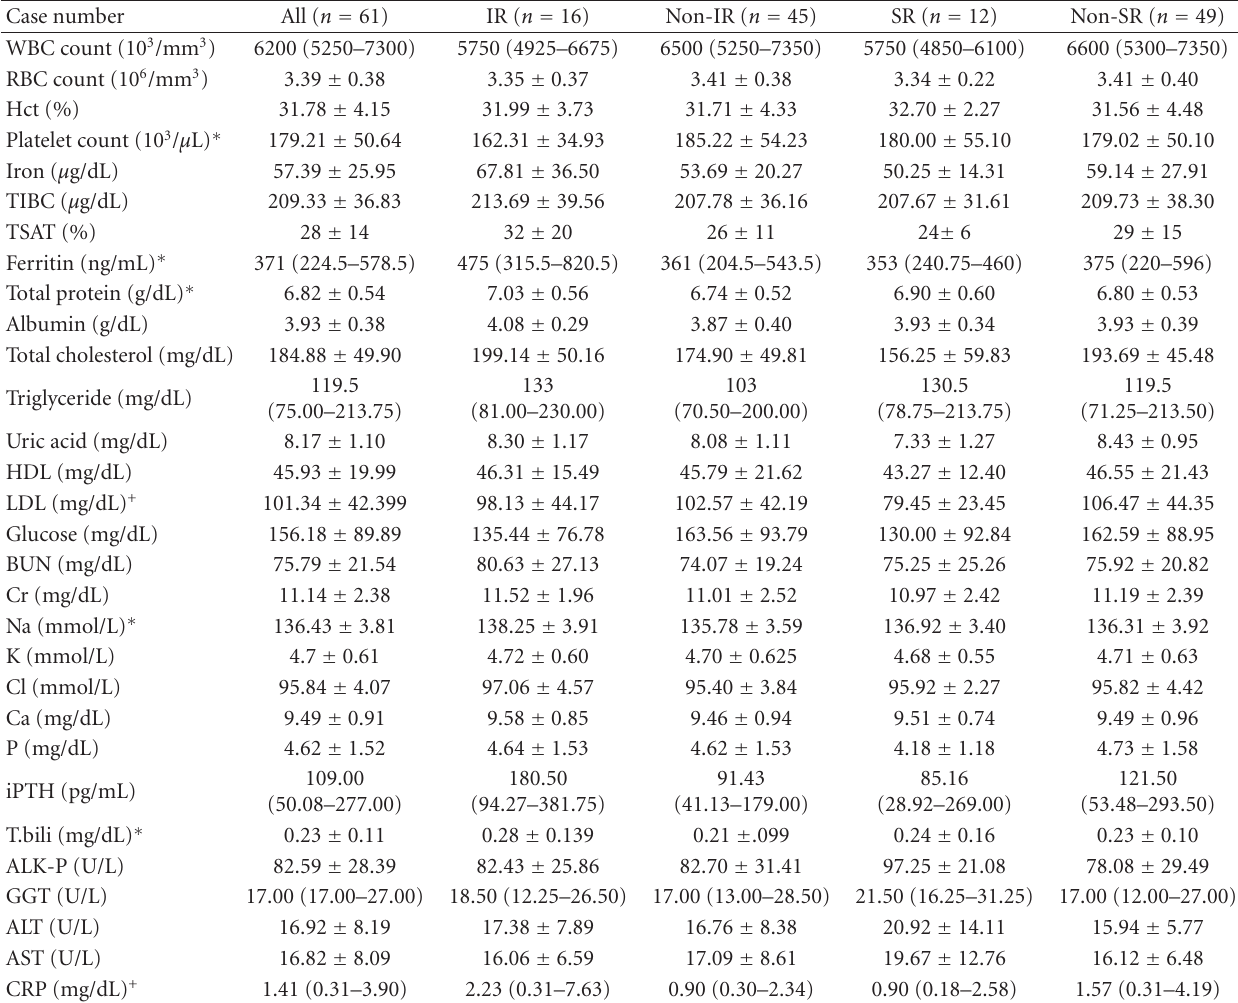
Table 2: Comparison of the baseline laboratory parameters among all study patients, initial responders (IR), the rest of the study patients (Non IR), sustained responders (SR) and the rest of the study patients (Non-SR) after treatment of CERA.